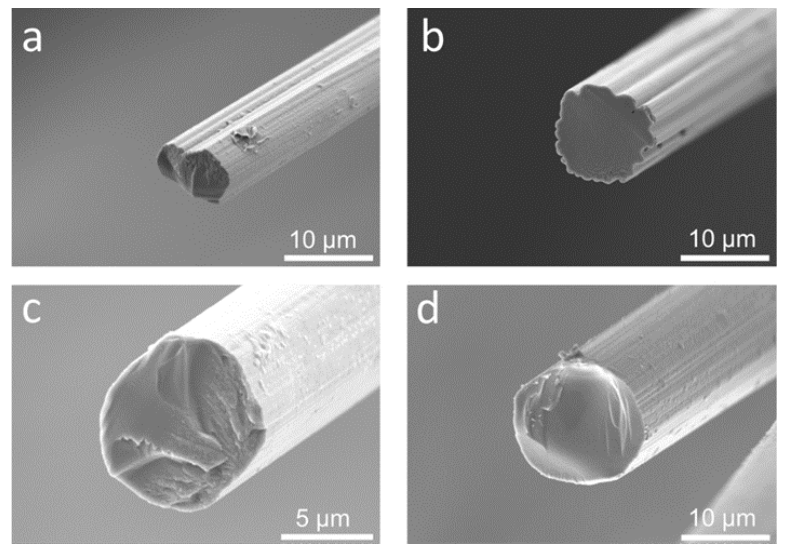
Figure 9. SEM images of batchwise-derived CFs from precursors spun with System S containing ( a ) 0 wt% and ( b ) 30 wt% lignin and from precursors spun with System P containing ( c ) 0 wt% and ( d ) 30 wt% lignin.